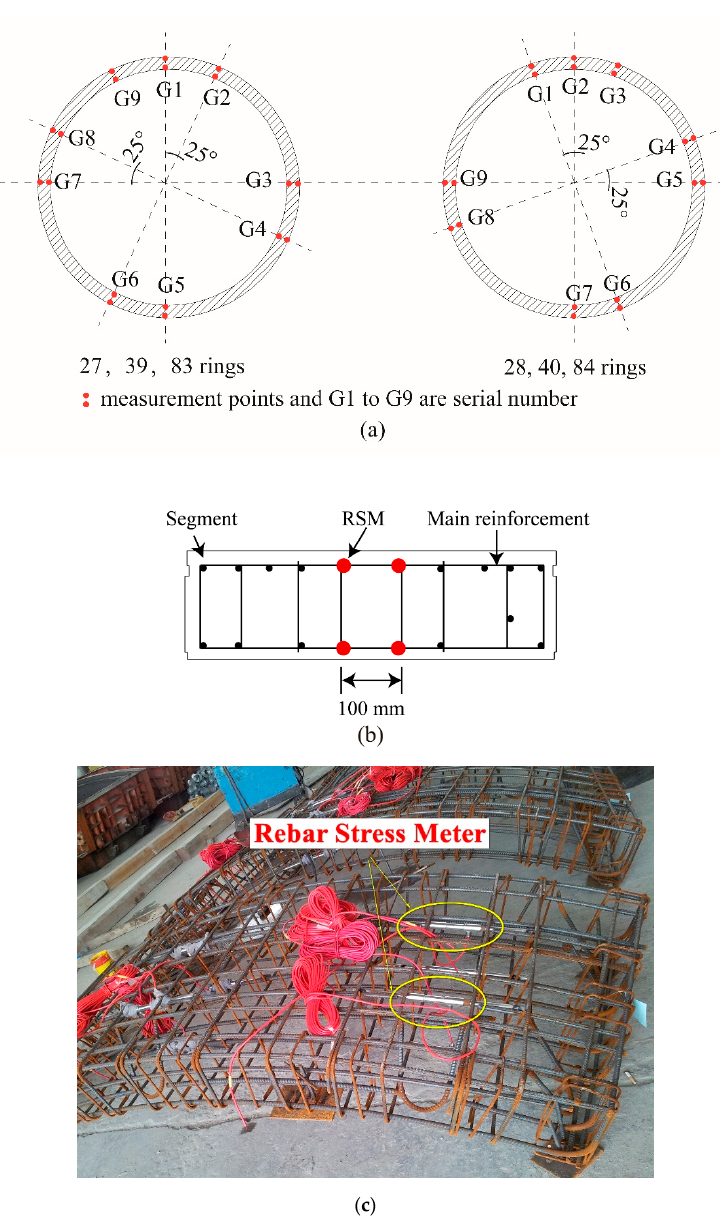
Figure 4. Rebar stress meters (RSMs) arrangement: ( a ) measurement point arrangement; ( b ) arrangement of each segment; and ( c ) welded RSMs prior to segment